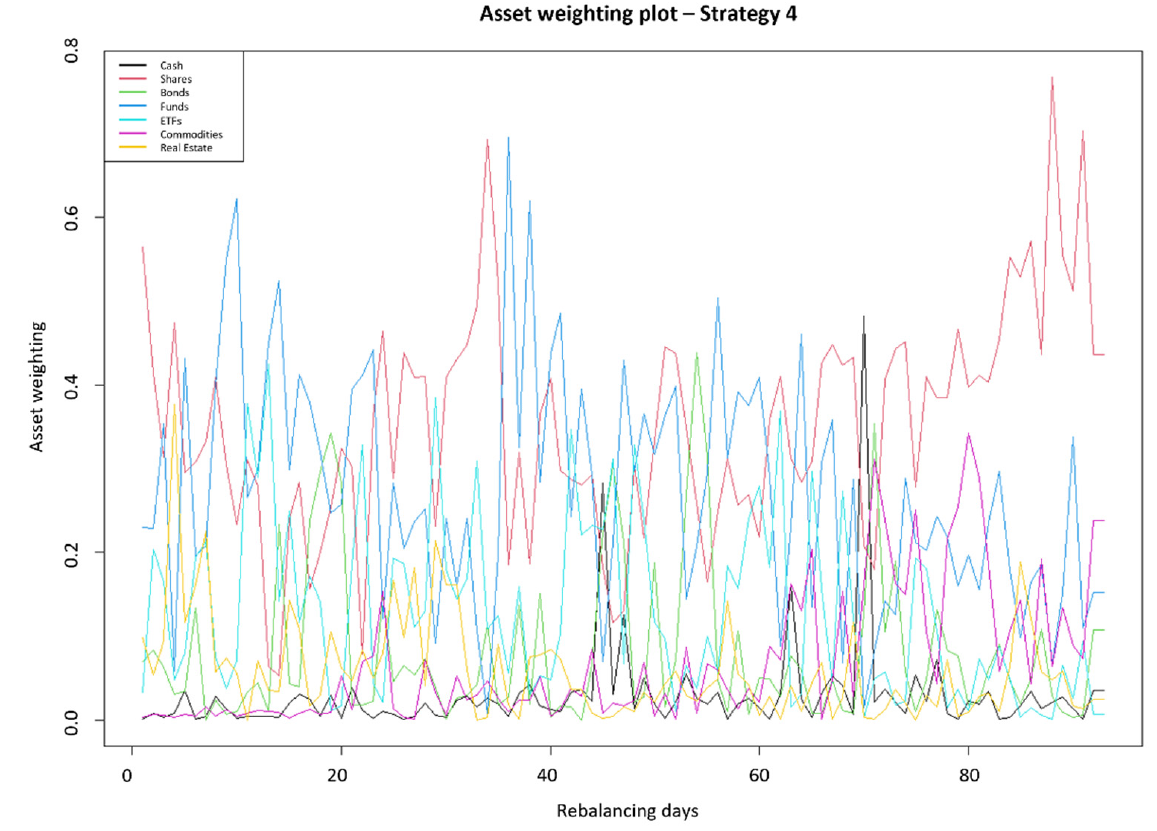
Figure 10. The asset weights plot of Strategy 4 .